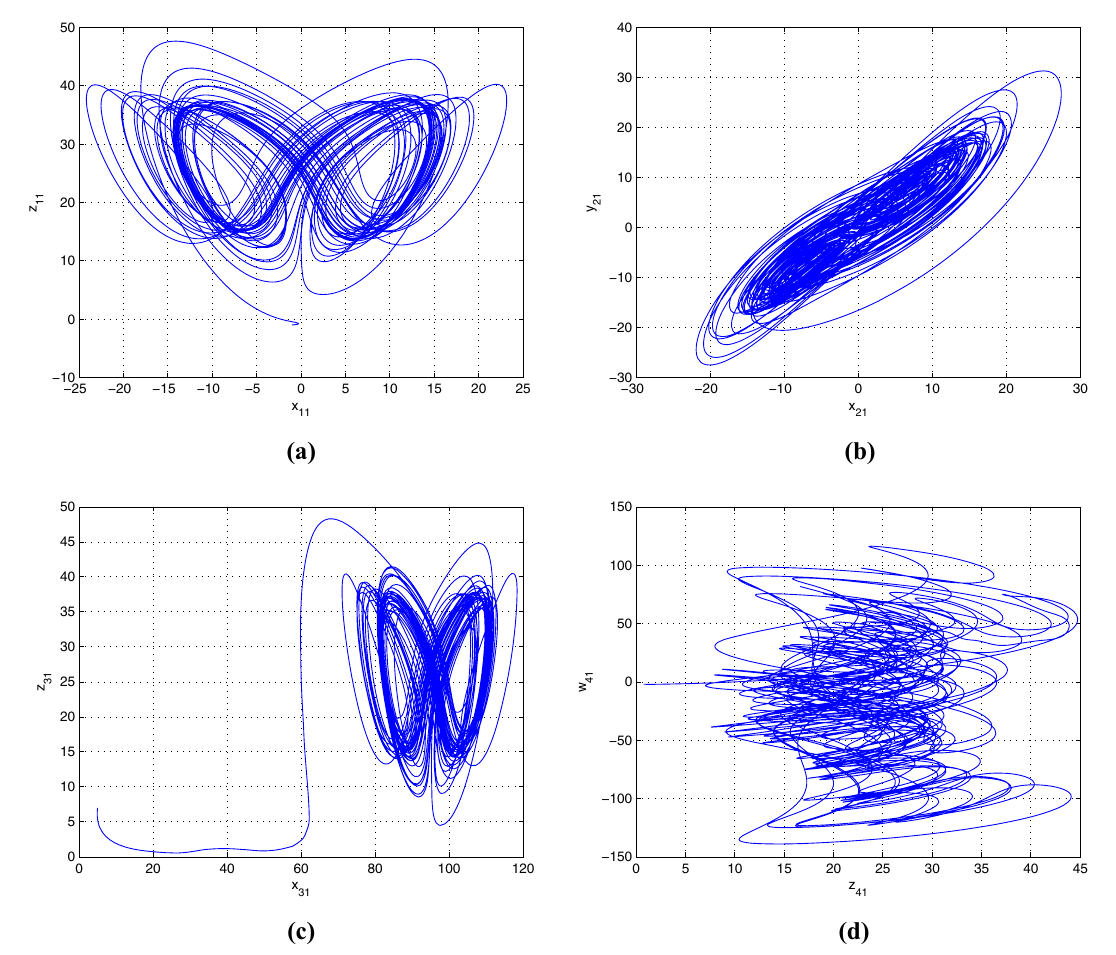
Fig. 1 Phase portraits of hyperchaotic systems a x 11 − z 11 -plane, b x 21 − y 21 -plane, c x 31 − z 31 -plane, d z 41 − w 41